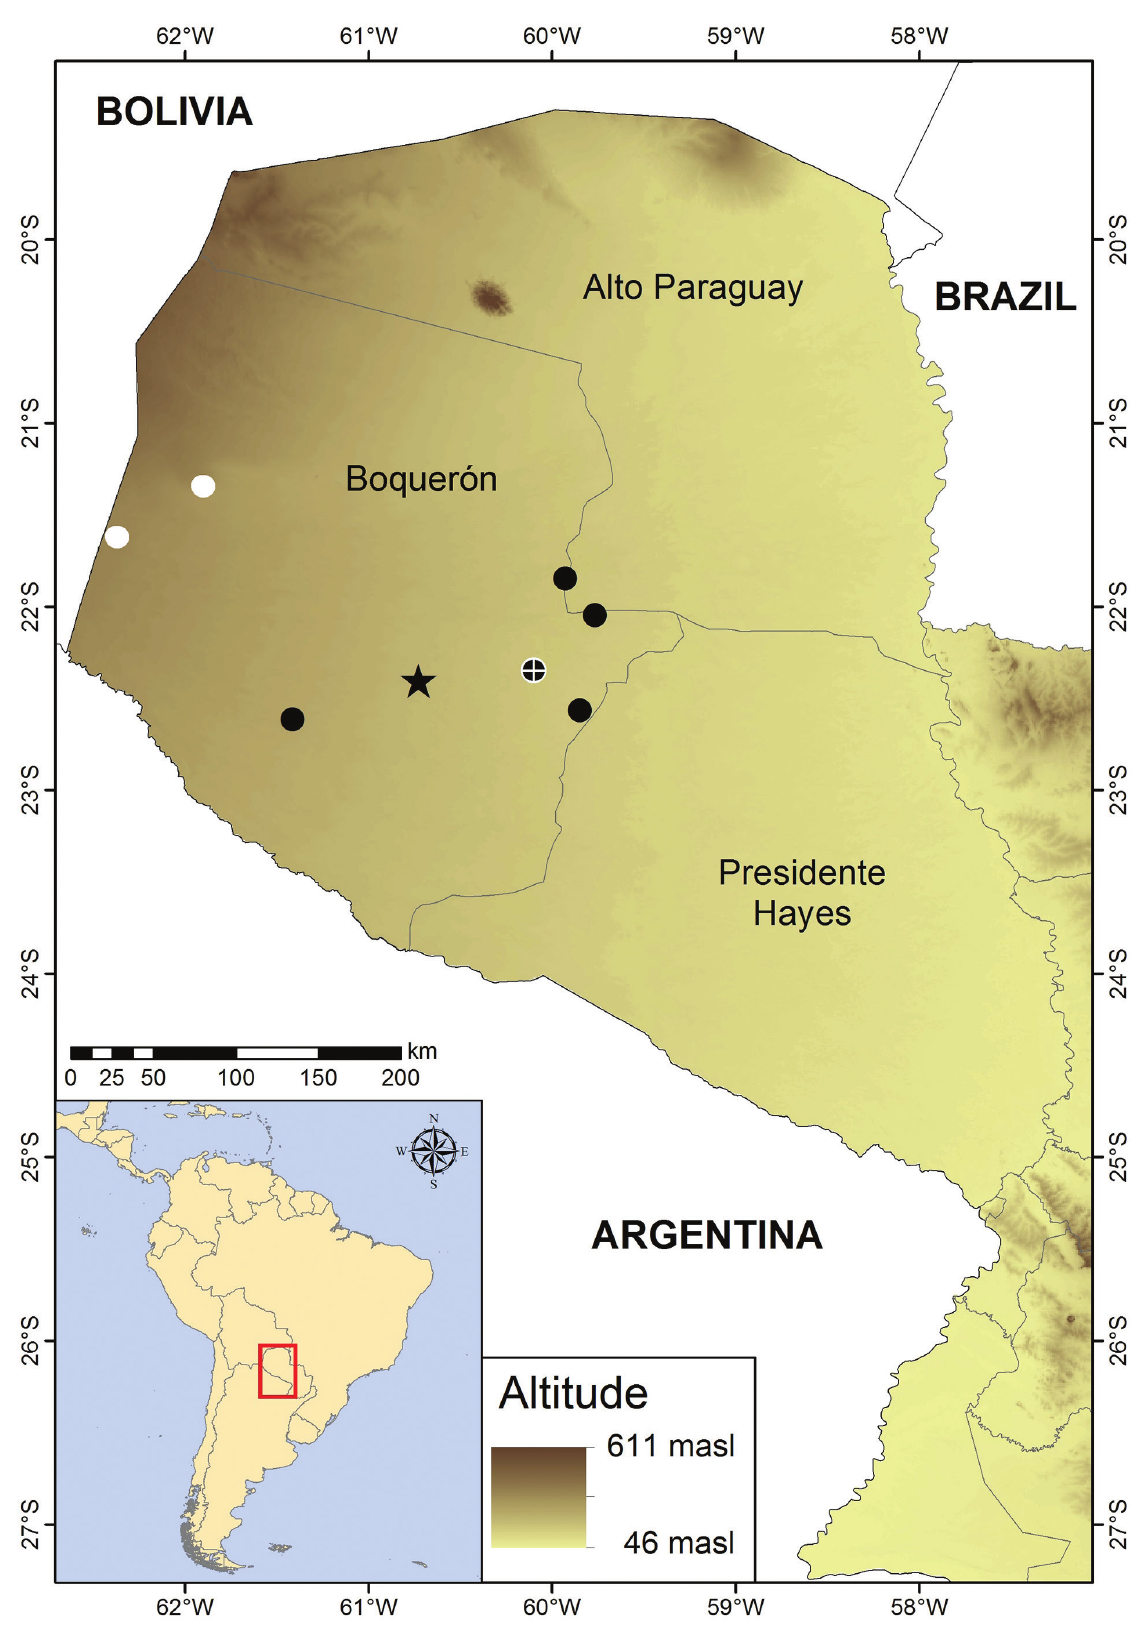
Figure 5. Occidental Region of Paraguay, indicating the political division, showing the known records for Homonota septentrion- alis (white circles) and the analyzed records of Homonota marthae (black circles), and its type locality (star). Circle with a white cross, indicates origin of the genetic samples. High resolution elevation base map (30 seconds resolution) taken from Consortium for Spatial Information (CGIAR-CSI) available on http://www.diva-gis.org/gdata (Jarvis et al.